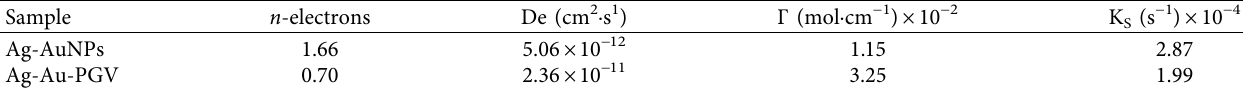
Table 2: Presentation of obtained Randles–Sevcik properties of Ag-AuNPs and Ag-Au/PGV bentonite composite.